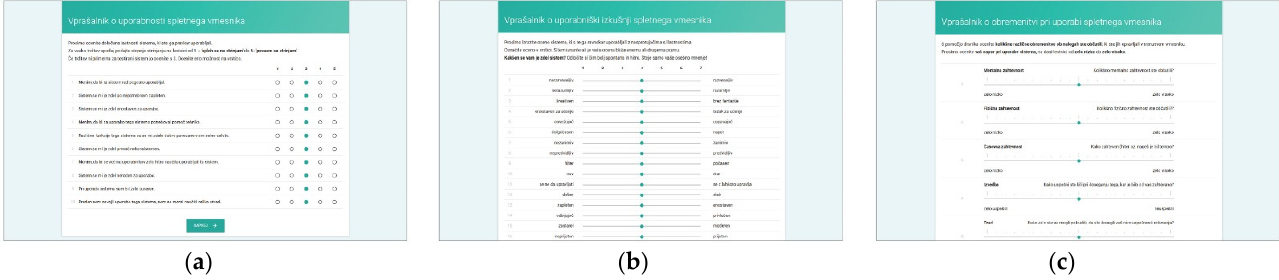
Figure 4. Testing platform interface displaying ( a ) SUS, ( b ) UEQ, and ( c ) NASA-TLX questionnaires.